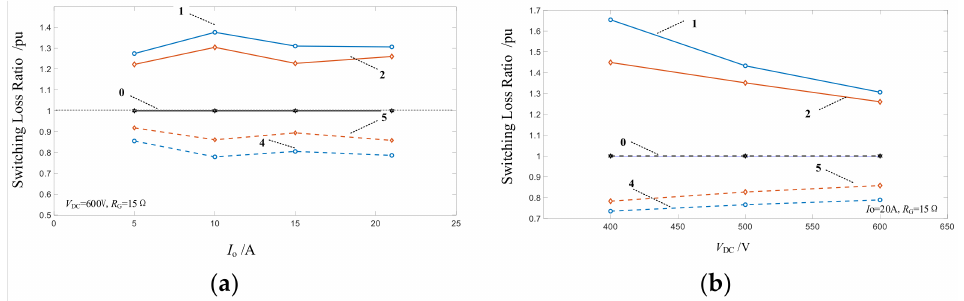
Figure 13. Switching losses of the SiC MOSFET with DC-side snubbers ( a ) at different I o and ( b ) at different V DC . (Note: 0: turn-on loss or turn-off loss with no C DE , 1: turn-on loss with C DE = 100 nF, 2: turn-on loss with C DE = 100 nF and R DE = 2.5 Ω , 4: turn-off loss with C DE = 100 nF, 5: turn-off loss with C DE = 100 nF and R DE = 2.5 Ω